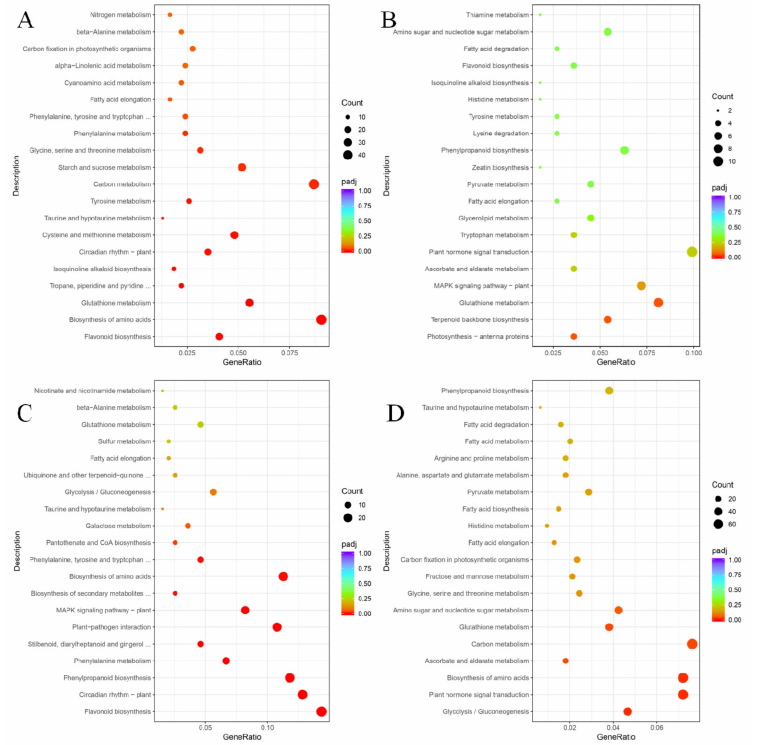
Figure 3. KEGG enrichment pathways of DEGs in different comparison groups. The size of the dot represents the number of differential genes enriched in different pathways, and their color represents the significance level of the difference. The gene ratio represents the ratio of the number of DEGs annotated to the KEGG pathway to the total number of DEGs. ( A , B , C , and D ) represent the comparison group of XFSUV vs. XFSCK, XFLUV vs. XFLCK, ZCSUV vs. ZCSCK, and ZCLUV vs. ZCLCK,